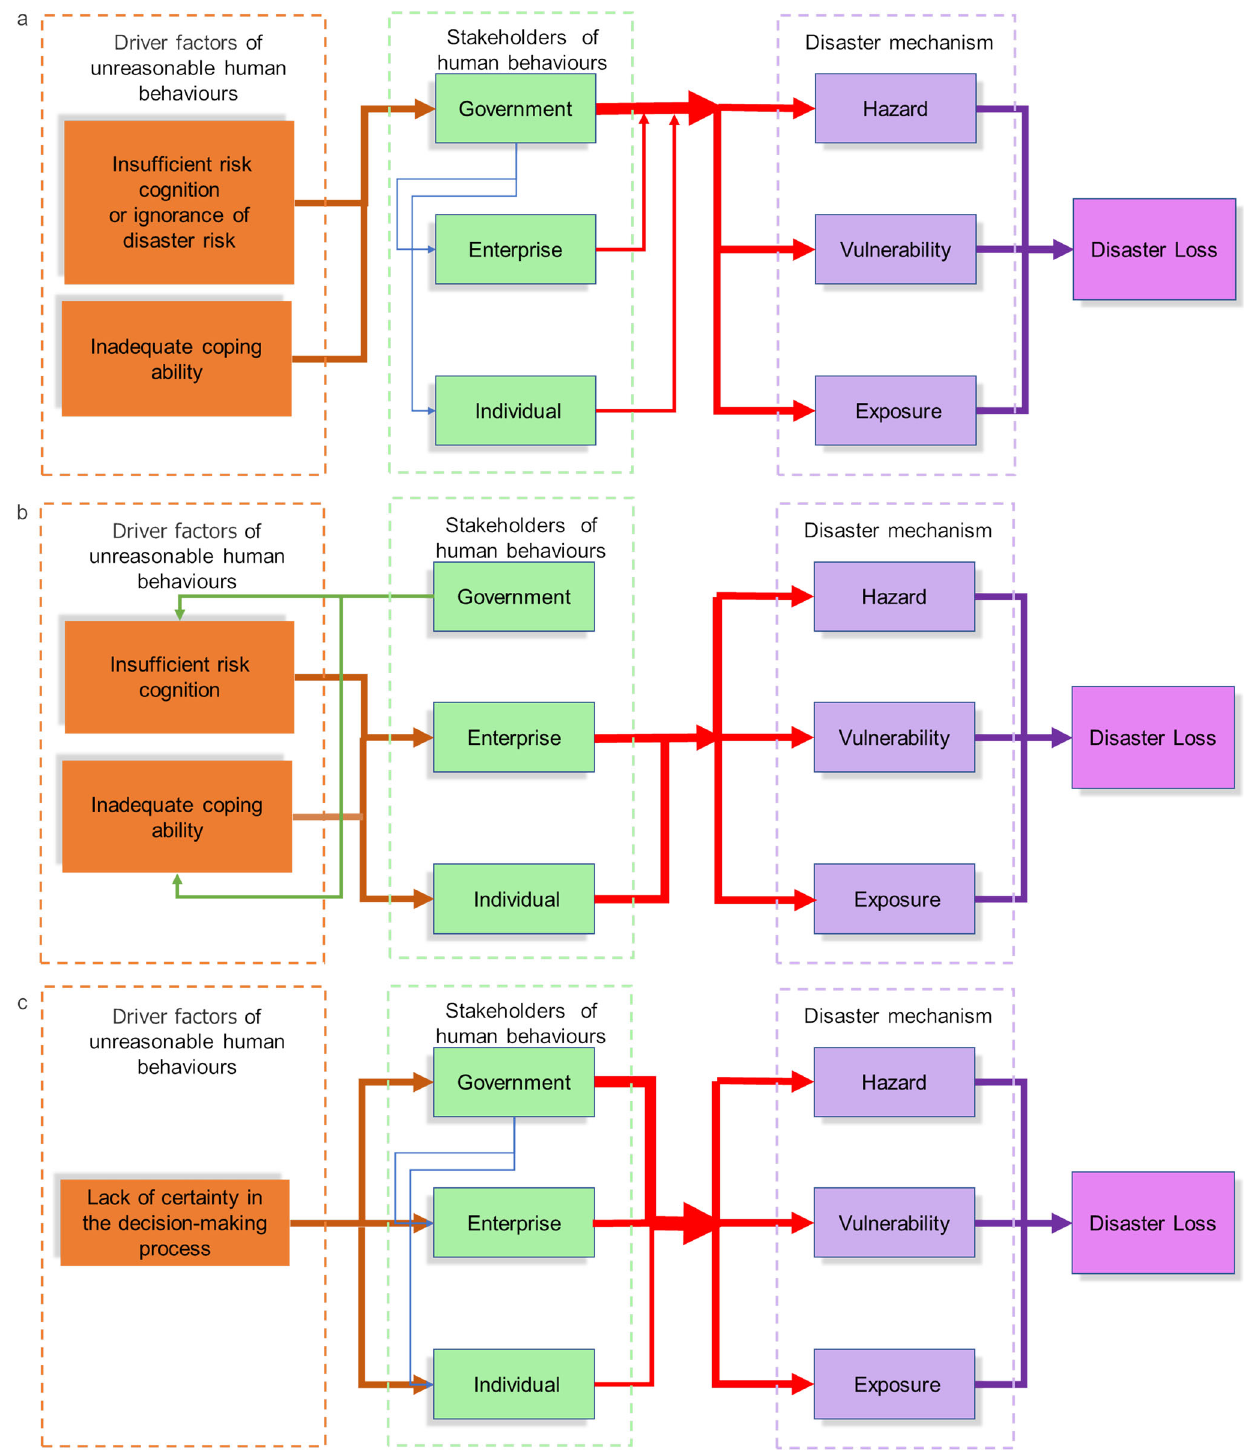
Fig. 5 Extended disaster risk framework, including unreasonable behavioural factors and a disaster mechanism. a Less-developed stage. b Relatively developed stage of dealing with normal disasters. c Relatively developed stage of dealing with extreme disaster events. The brown arrow represents the effect of driver factors on human behaviour stakeholders; the red arrow represents the magnifying effect of human behaviour stakeholders on the three components of disaster; the blue arrow represents the interaction between the various stakeholders of human behaviours; and the green arrow represents the in fl uence of behaviour stakeholders on driver